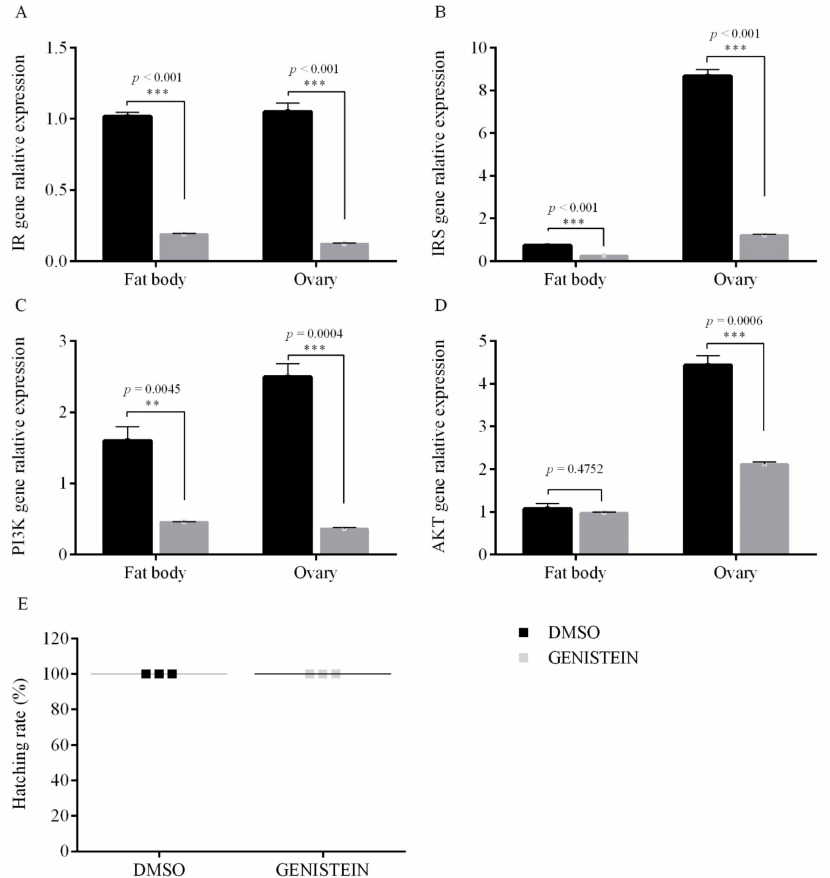
Figure A4. Gene relative expression, phosphorylation level, energy metabolism and egg hatching incidence after injection of adults with the PTK inhibitor genistein compared to DMSO (control) under long photoperiod conditions (L16:D8). ( A ) IR gene, ( B ) IRS gene, ( C ) PI3K gene, ( D ) AKT gene in the fat bodies and ovaries, ( E ) egg hatching incidence. Data are the mean ± SEM from three independent replicates, the gray bar indicates PTK inhibitor treatments, while the black bar indicates DMSO controls (** p < 0.01 and *** p < 0.001 vs. DMSO controls as assessed, Student’s t